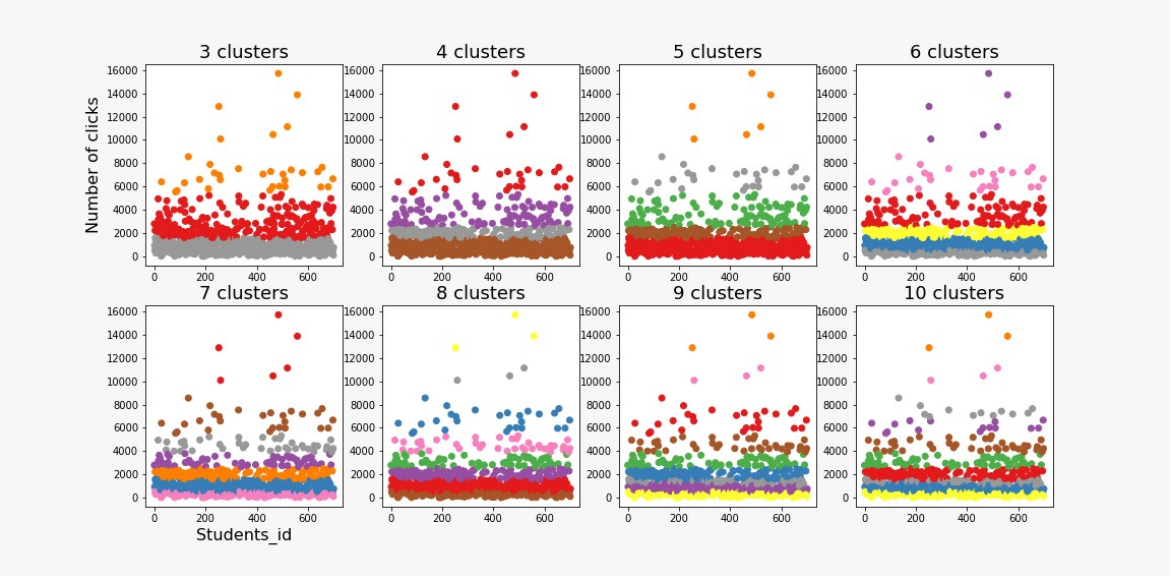
Clustering Using the Agglomerative Hierarchical Clustering